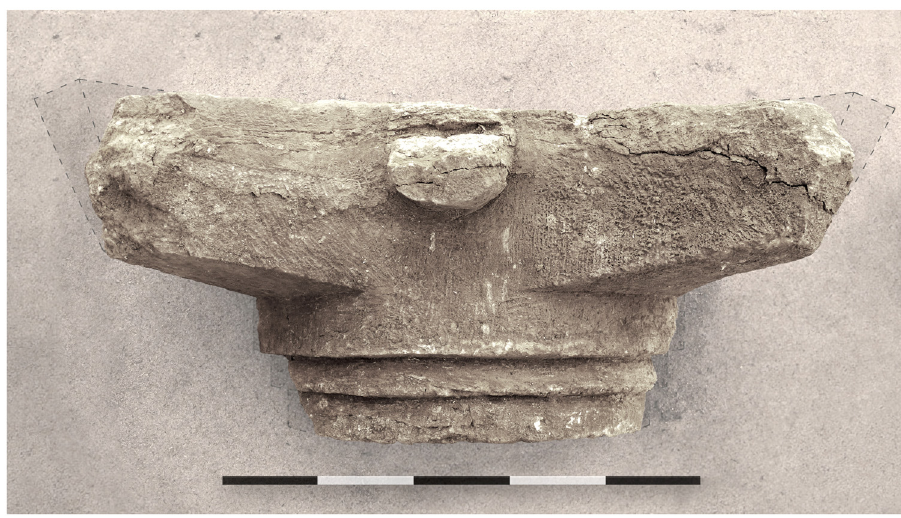
Figure 5: Blocked - out capital from Berenike trench BE19 - 122 photograph ( not orthophoto view ) , scalebar measures 50.0 cm ( photography: M. Bergmann )